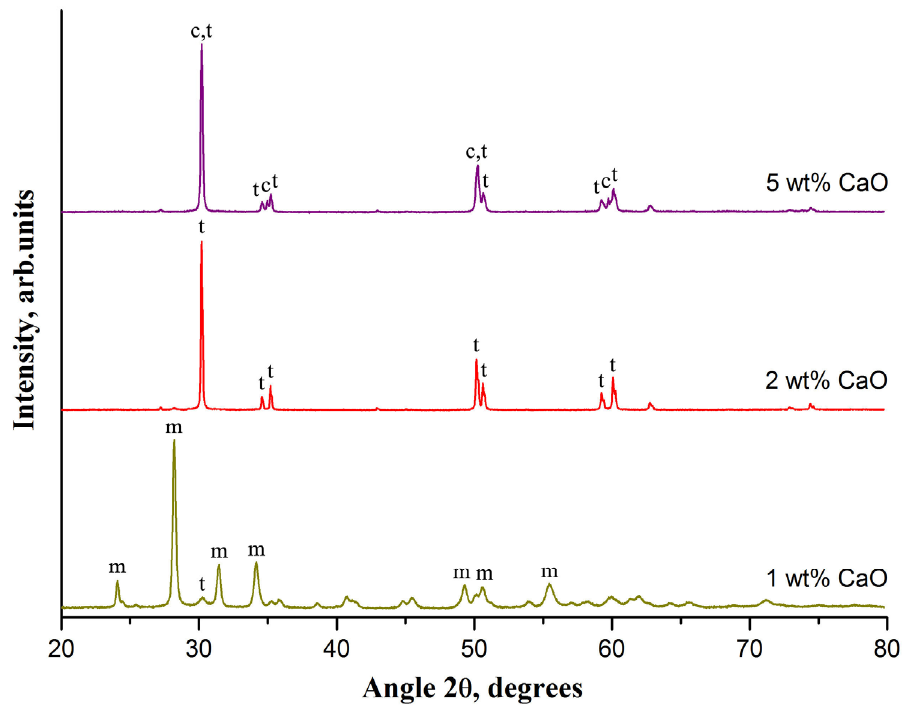
Figure 1. The XRD patterns of a CaO-ZrO 2 ceramic sintered at 1300 °C containing different dopant amount; m, t, c—the most intense characteristic peaks of m-ZrO 2 , t-ZrO 2 and c-ZrO 2 , respectively.